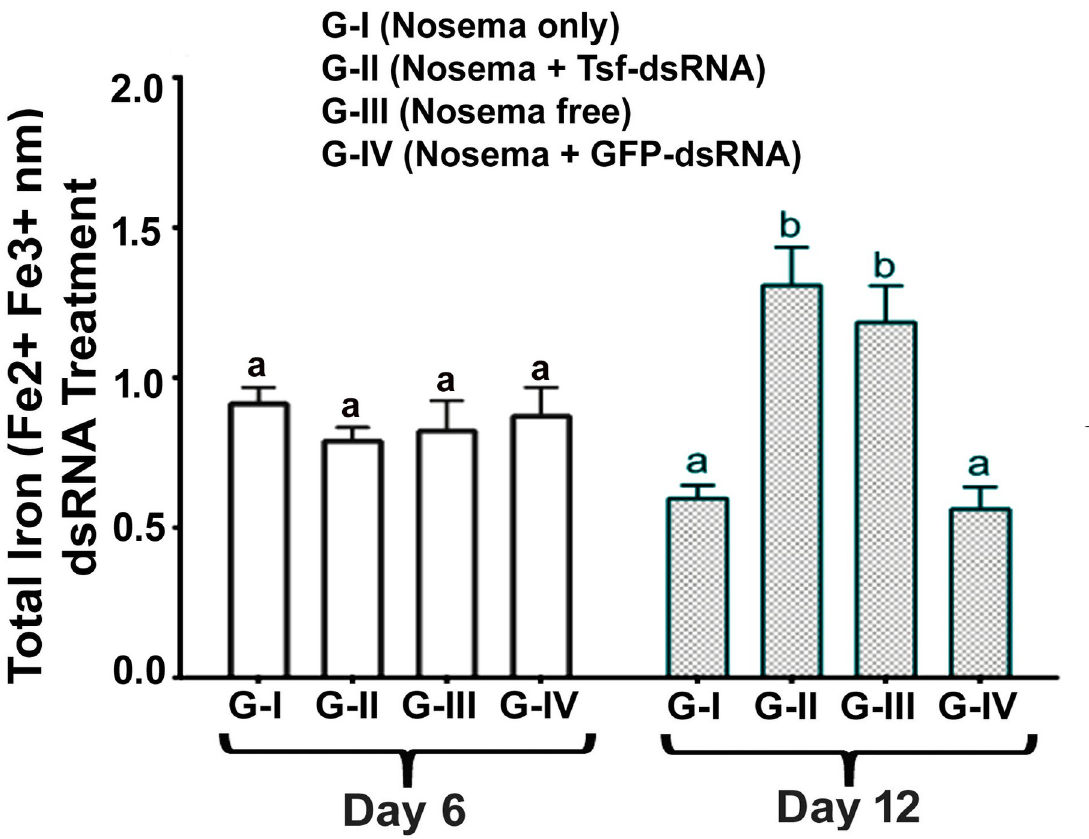
Fig 8. Total amount of iron in bees on day 6 and day 12 post AmTsf -dsRNA treatment. A star denotes a calibrator and the different lower-case letters above bars indicate the statistically significant difference among different groups ( P � 0.05, ANOVA and Tukey´s tests).